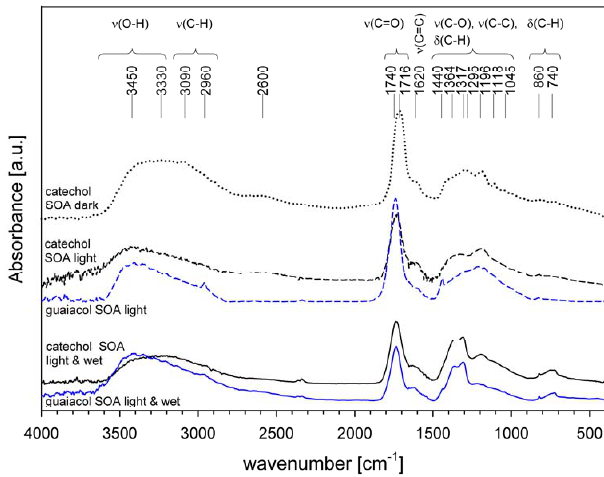
Fig. 7. Transmission difference spectra of the two aerosol precursors compared to the formed SOA at different ambient conditions after 30 minutes. The spectra are calculated by dividing the single spectra of the different aerosols after 30 minutes formation by the single spectra at the beginning of aerosol formation. Assignments of the observed bands are listed in Table 1.